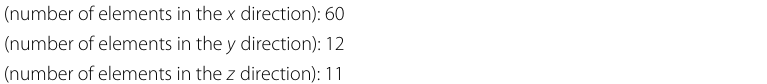
Table3 Parameters values used in the simulation for the reference solution N x (number of elements in the x direction): 60